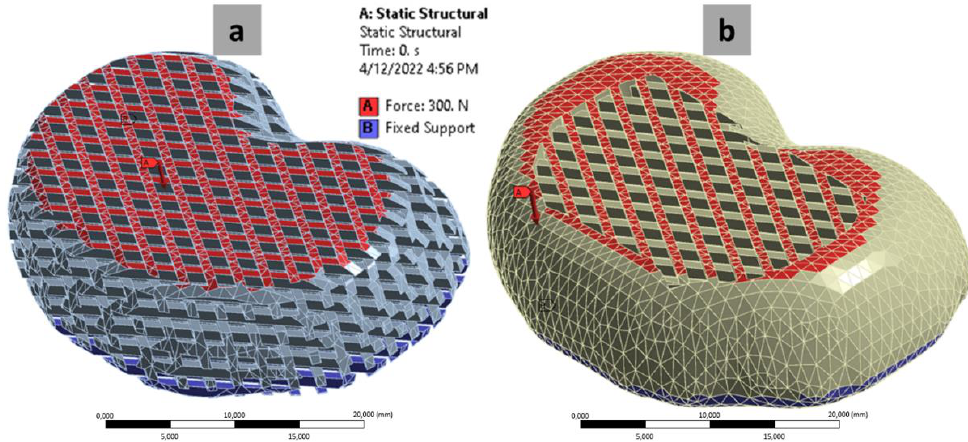
Figure 3. FEA mechanism illustrations of MTDR with FLC ( a ) and ABC ( b ).